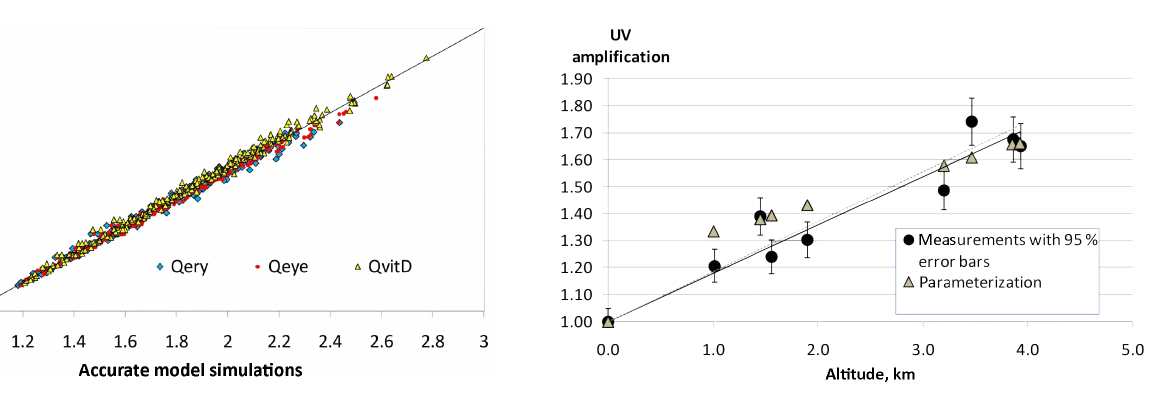
Figure 8. The comparison between the simulated UV amplification according to the proposed parameterization and the UV amplifica- tion from the experimental data as a function of altitude. Moscow State University data set. Solar elevation h = 50 ◦ . Clear sky con- ditions. Note: since we used the data of different field campaigns the ozone altitude gradient differed from the typical value. The to- tal ozone was equal to X ∼ 300DU at H = 0km, X ∼ 240DU at H > 3km and X ∼ 250DU at H ∼